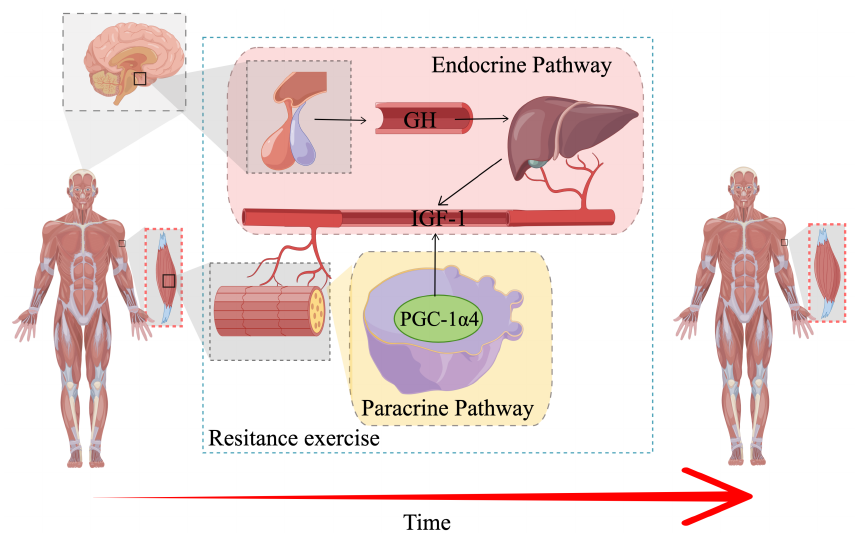
Figure 7. Schematic of the Major Signaling Pathways Involved in the Control of Skeletal Muscle